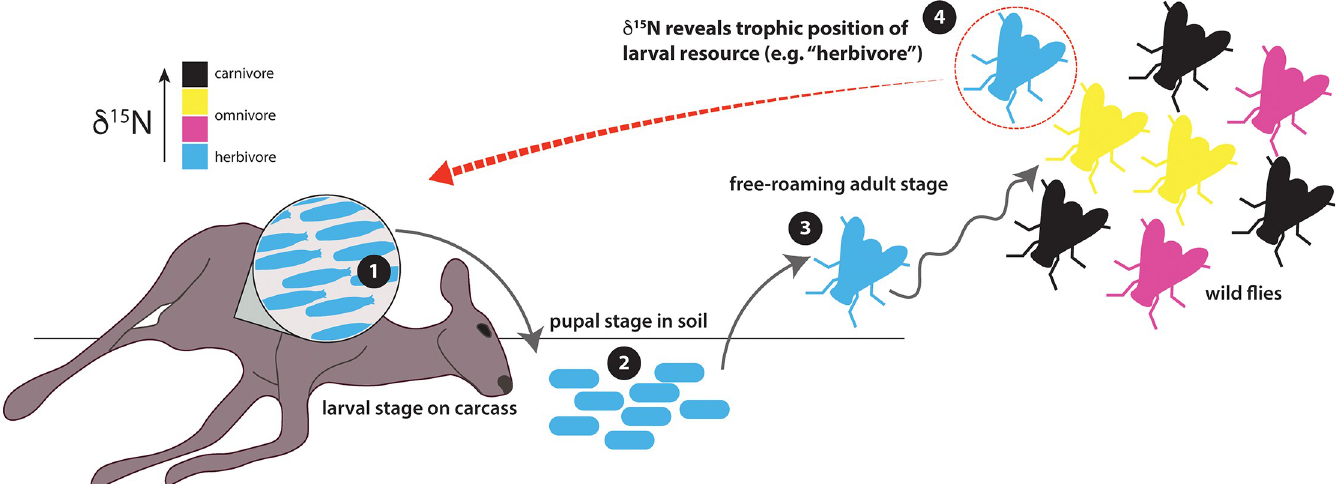
Fig 1. Schematic illustrating the concept for determining trophic position of the carcass. 1) Blow fly larvae develop on a carcass (e.g., a deer) by consuming the animal’s tissue. 2) Larvae leave the carcass in order to pupate in the soil. 3) Adult blow flies emerge from puparia approximately 2 weeks after initial pupation and begin the free-roaming stage of their life cycle. 4) Analysis of a random adult blow fly can reveal the trophic position of the animal on which it developed as a larva. Different colors represent different carcass trophic positions and thus the variable isotopic signatures present within wild populations of adult blow flies. In the example illustrated here, the adult blow fly retains the δ 15 N value of the carcass (“herbivore”) from its larval stage.